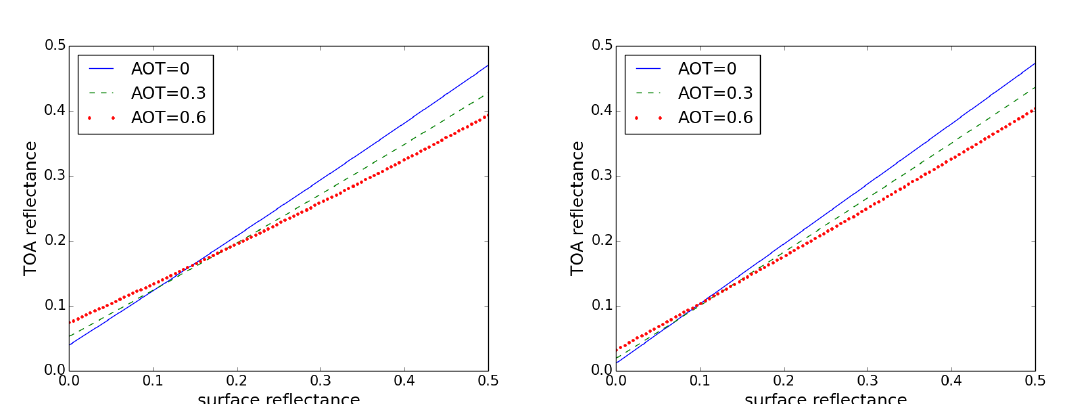
Standard deviation of surface reflectance due to an error on aerosol optical thickness (AOT) of 0.04 (dashes) or 0.08 (line) at 550 nm, as a function of surface reflectance, for two values of the input AOT: left for the red band of Formosat-2; right for the NIR band of Formosat-2. The minimum of the curves corresponds to the “critical” range in surface reflectance for which the TOA reflectance is not sensitive to AOT, because when AOT increases, the atmospheric transmission decreases as the path radiance increases (see Figure 2).